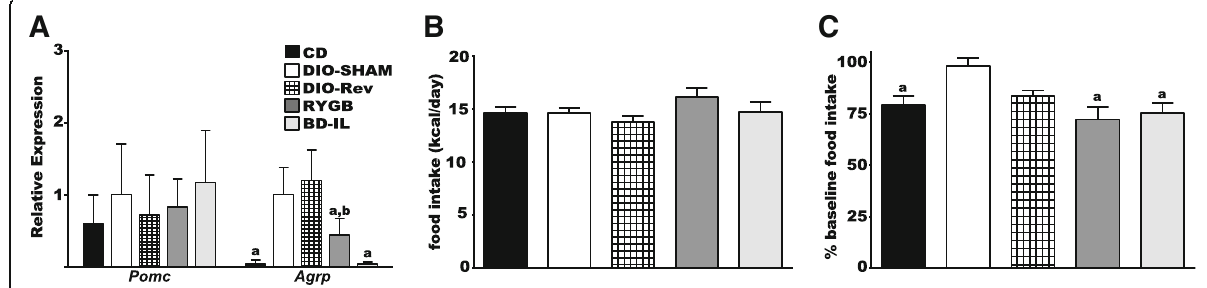
Fig. 5 Hypothalamic neuropeptide gene expression and anorexic response to RYGB and BD-IL bariatric surgery. a Expression levels of hypothalamic neuropeptides ( b ) Baseline food intake measured over three days and expressed in kcal/day per mouse. c Anorexic response to exogenous leptin. a=significant difference from DIO-SHAM. b=significant difference from CD. p <0.05 ( n =6 – 8 per group). Data are represented as